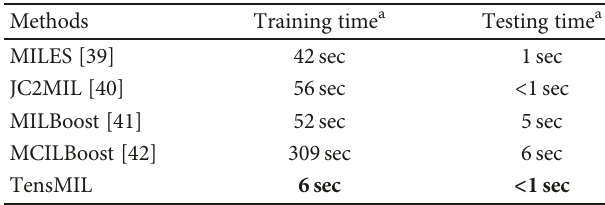
Table 5: Mean CPU running time over the 10 cross-validation folds for the MIL classi fi cation